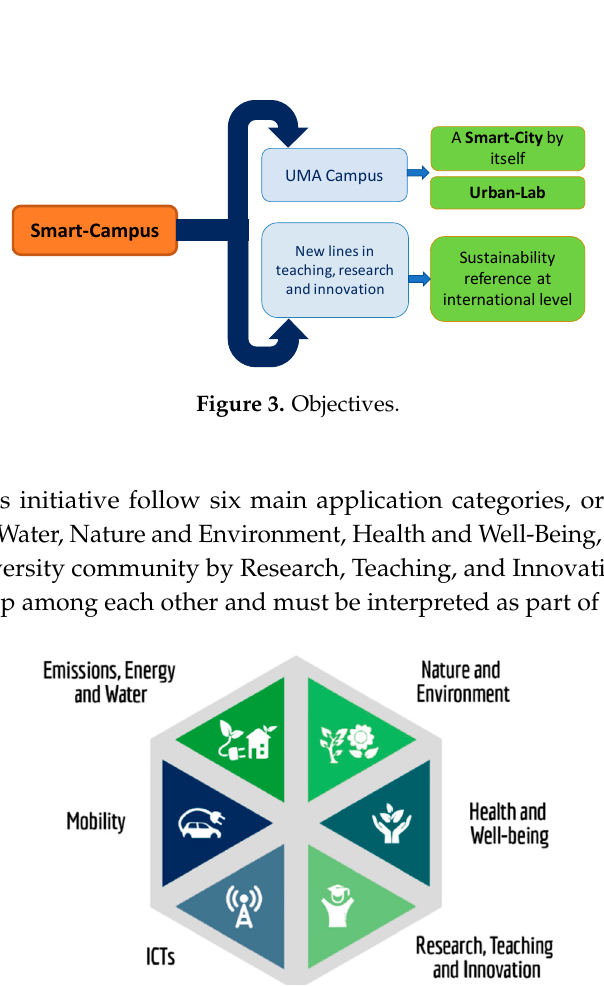
Figure 4. UMA Smart-Campus (SmartUMA) application categories (pillars).